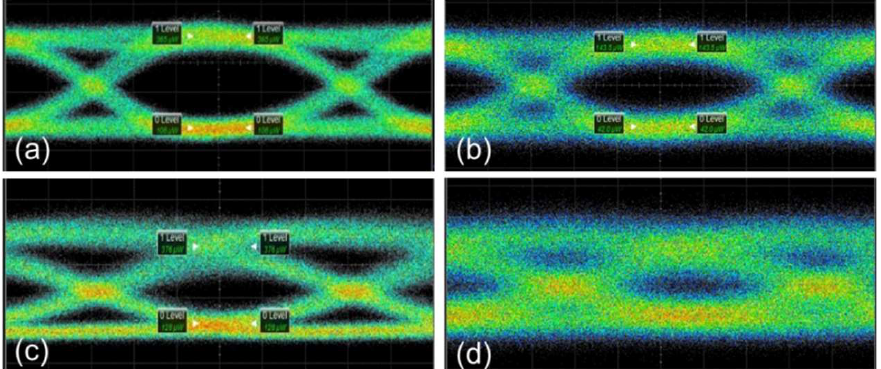
Figure 7. Eye diagrams of 25 Gb/s and 50 Gb/s: ( a ) 25 Gb/s BTB eye diagram, ( b ) 25 Gb/s eye diagram after 25 km transmission, ( c ) 50 Gb/s BTB eye diagram, ( d ) 50 Gb/s eye diagram after 10 km transmission.